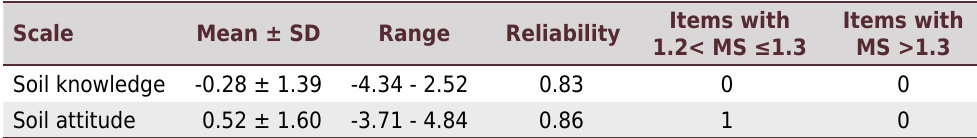
Items with Items with 1.2< MS ≤1.3 MS >1.3